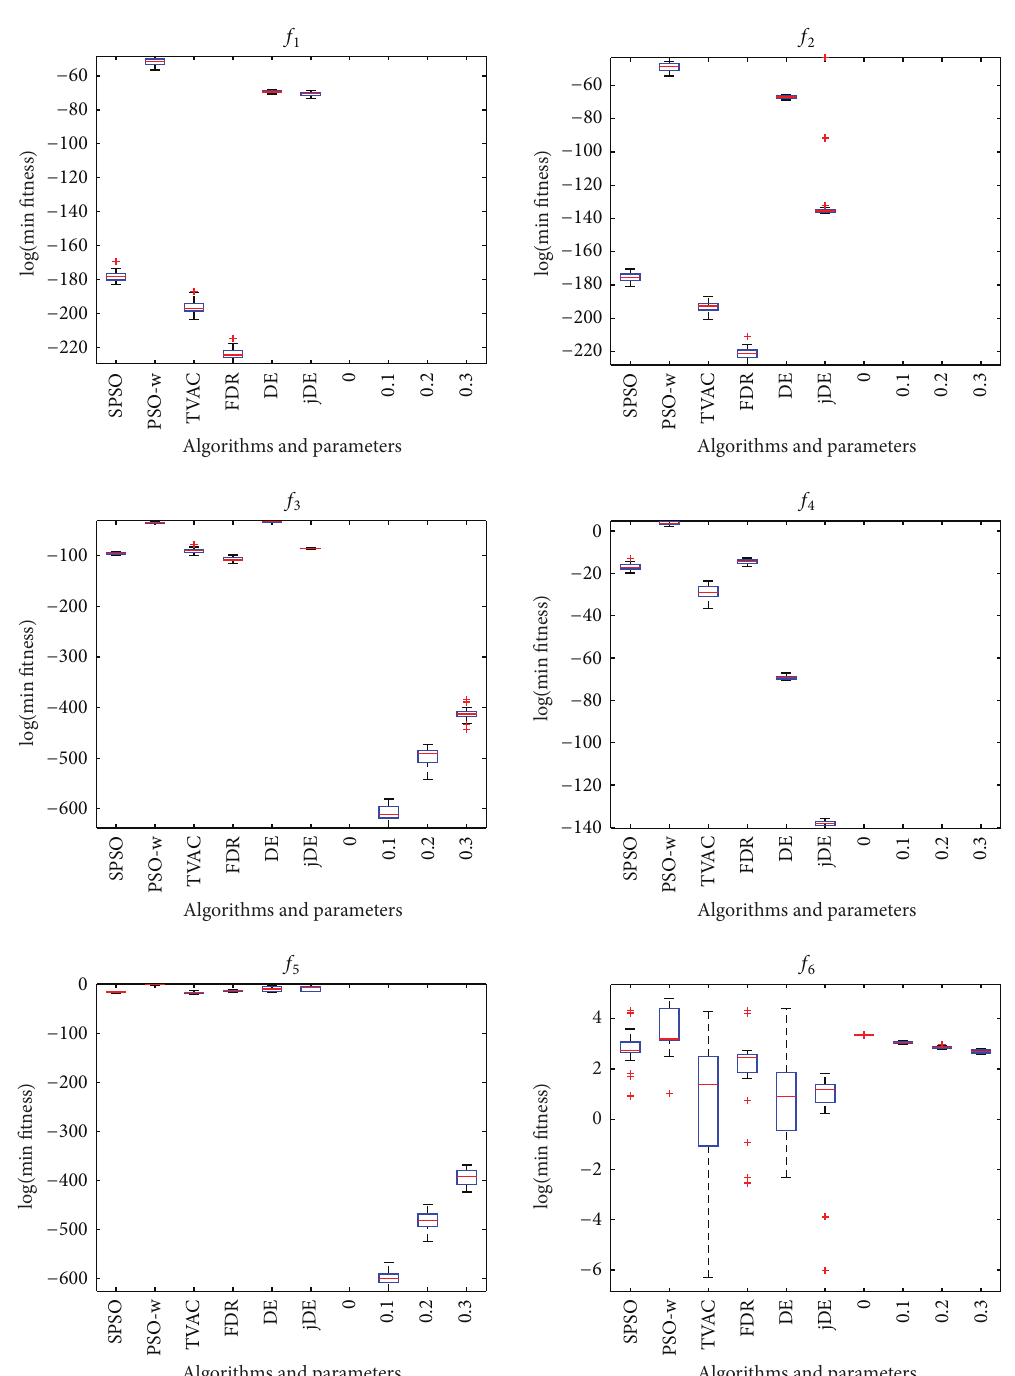
Figure 4: HPSO-DE with different balance parameters and other six algorithms on 𝑓 1 , 𝑓 2 , 𝑓 3 , 𝑓 4 , 𝑓 5 , and 𝑓 6